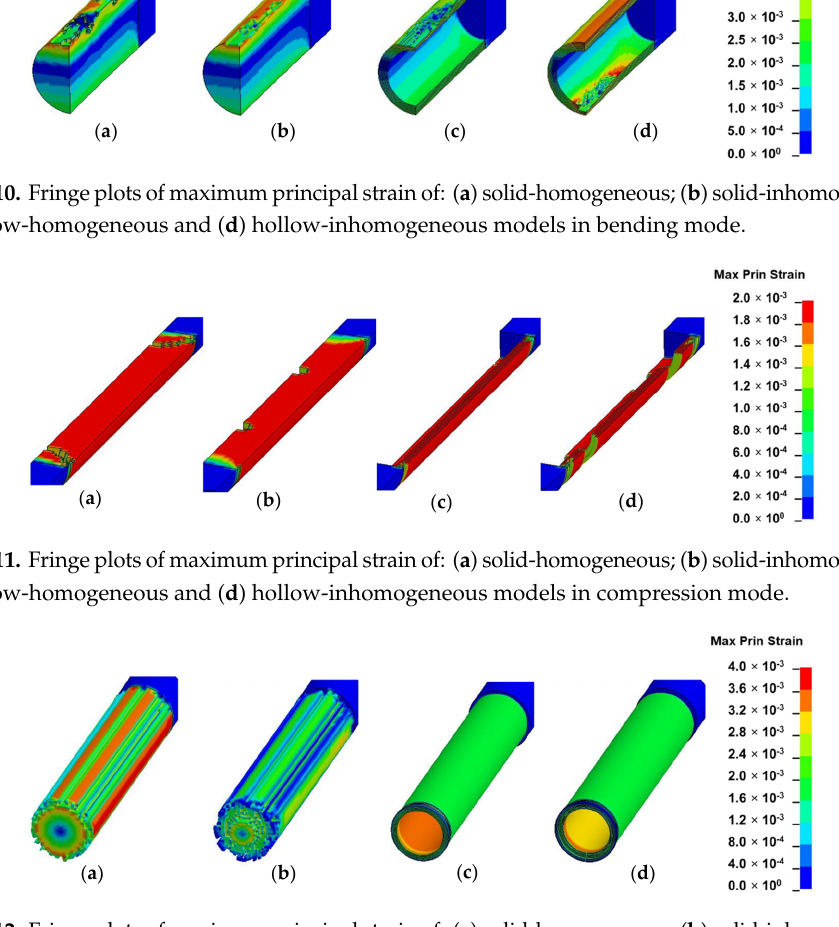
Figure 13. Fringe plots of maximum principal strain of: ( a ) solid-homogeneous; ( b ) solid- inhomogeneous; ( c ) hollow-homogeneous and ( d ) hollow-inhomogeneous models in shear mode. The following key observations were made from each mode of loading of the hollow- inhomogeneous model. In bending mode, cracks, which initiated from the lower innermost wall section of the culm, propagated in a longitudinal and radially outward direction in a splitting-like pattern. In the compression mode, cracks originated simultaneously from the outermost wall of the node-internode sections. They followed a diagonal pathway towards the middle of the internode and moved radially inwards. In the torsion mode, however, crack initiation was only observed at the outermost wall section of the prescribed end. Subsequent propagation affected the outermost wall section followed by the node-internode section of the fixed end. Radial penetration was observed at both ends. In the shear mode, a crack was observed to be initiated at the innermost wall of the internode middle section. The crack propagated radially outwards in a splitting-like pattern.